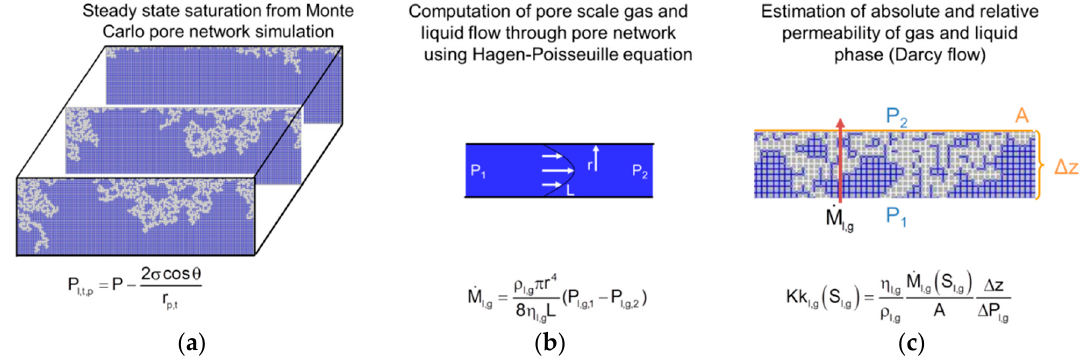
Figure 4. Extraction of efficient transport parameters based on PNMCSs. ( a ) Step 1: Computation of the steady state invasion patterns at the disconnection of the water supply route by PNMCS. ( b ) Step 2: Computation of the pore scale fluid flow based on the patterns obtained from step 1. ( c ) From the flow rates in step 2, the relative and absolute permeabilities of the PN are computed in step 3 on the Darcy scale.